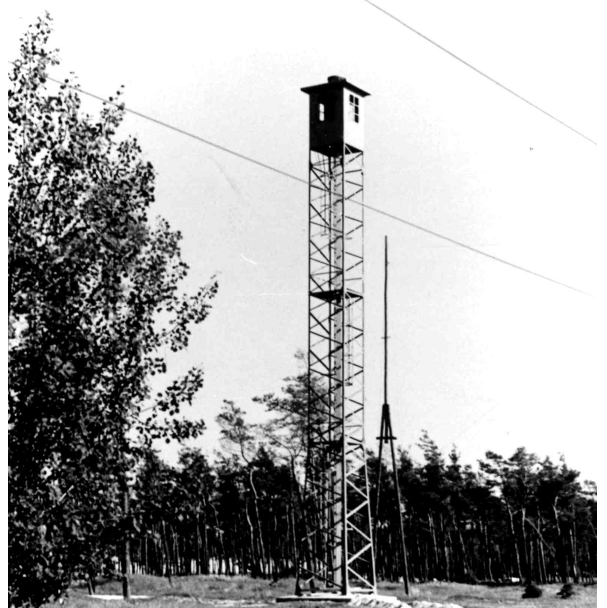
Figure 22. In 1960, for the A1 sounders at 3.18 and 3.86MHz, a freestanding 20m tower was erected. It carried four half-wave dipoles for transmitting and receiving. From 1961, the A1 sounders at both frequencies operated continuously.